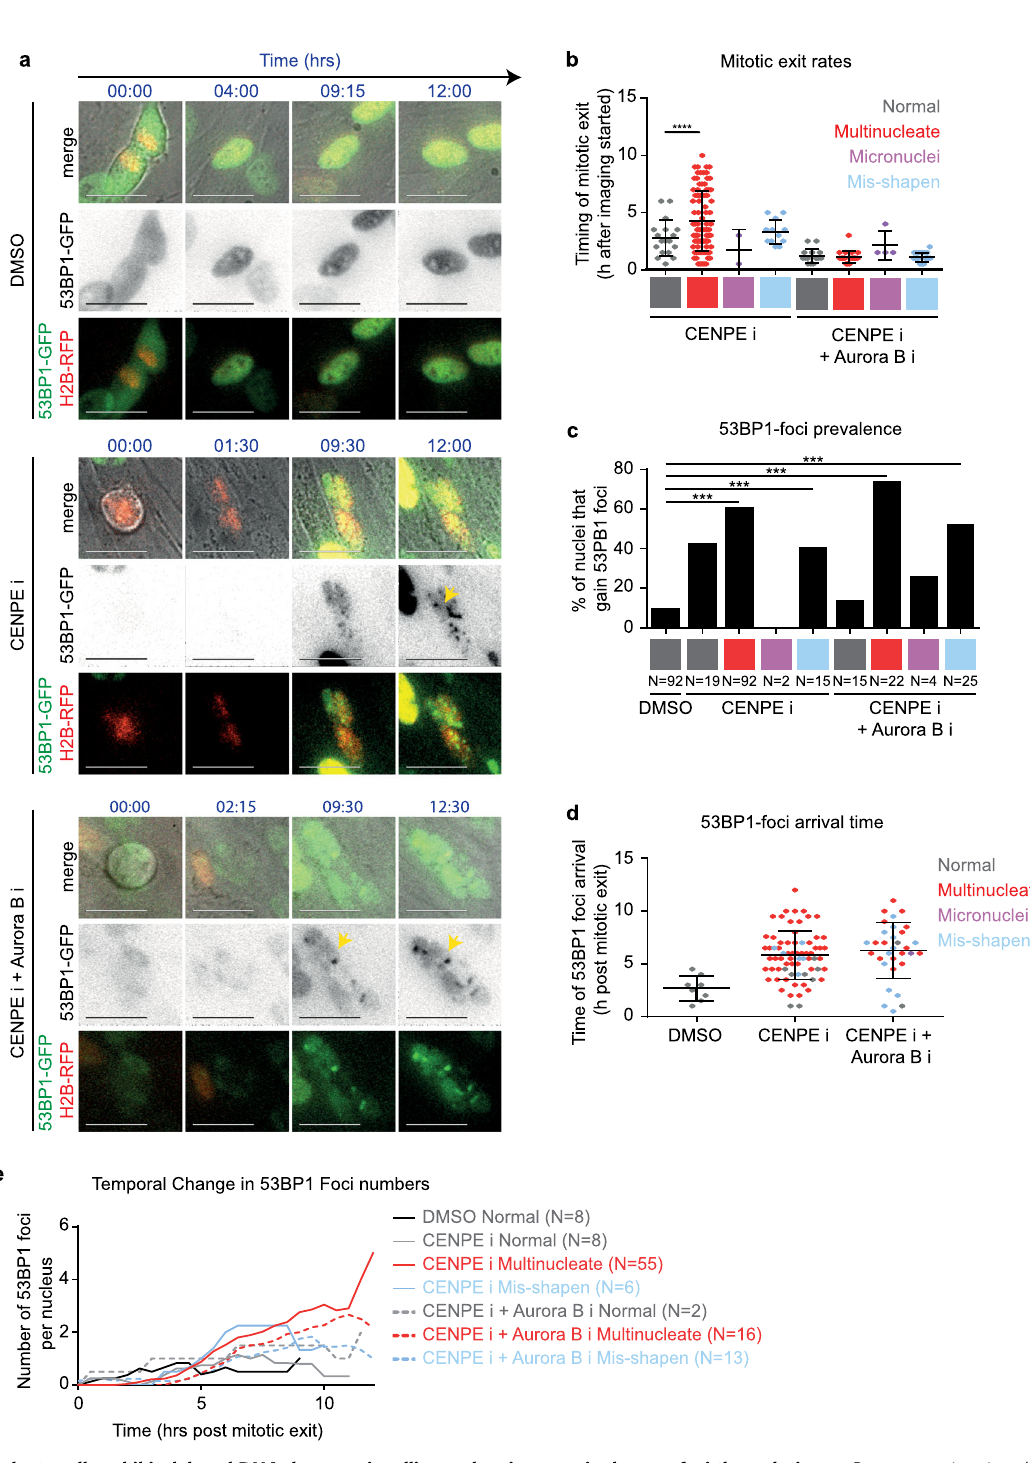
Fig. 2 Multinucleate cells exhibit delayed DNA damage signalling and an increase in damage foci through time. a Representative time-lapse images of normal shaped nuclei exiting mitosis after DMSO treatment, or multinucleated cells exiting mitosis after CENPE i or CENPEi and Aurora Bi treatment as in Supplementary Fig. 5a. Scale 25 μ m. Yellow arrows indicate 53BP1-GFP foci within multinucleate cells. In the 53BP1-GFP lane, GFP intensities are inverted to highlight 53BP1-foci as soon as they form (associated supplementary movies present non-inverted GFP intensities). b Graph shows the timing of mitotic exit, based on nuclear morphology of daughter cells (indicated by colour). Statistical signi fi cance was assessed using an unpaired student ’ s t test. **** indicates p < 0.0001. c Graph of the proportion of daughter nuclei which gain 53BP1 foci during time-lapse imaging. N values below bars indicate the number of nuclei from at least three independent experimental repeats. Statistical signi fi cance was assessed using a proportions test with 95% con fi dence interval. *** indicates p < 0.001. d Graph of the timing of 53BP1 foci arrival in nuclei which gain 53BP1 foci, after drug treatments as indicated. Time-lapse movies as in Fig. 2a were used to determine the earliest time-point of visible 53BP1 foci following mitotic exit. Each value represents one nucleus. The colour of plotted values represents nuclear morphology. e Quanti fi cation of 53BP1 foci number per nucleus over time from mitotic exit.